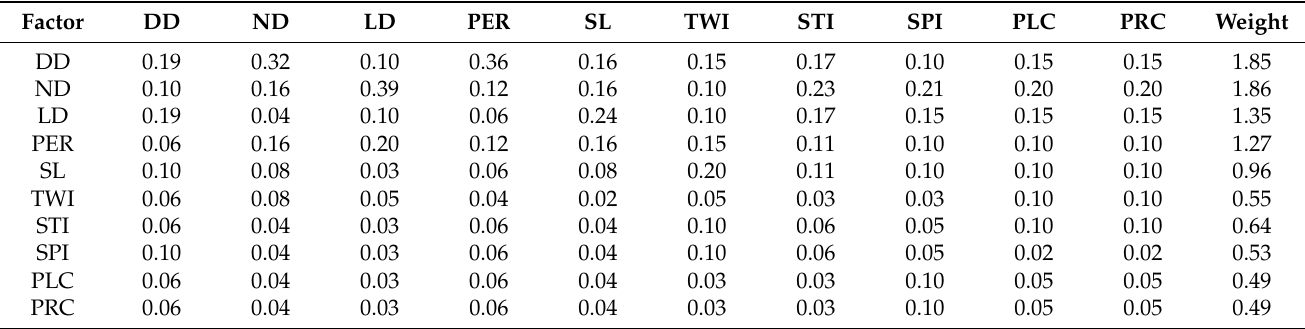
Table 3. The weighting of the